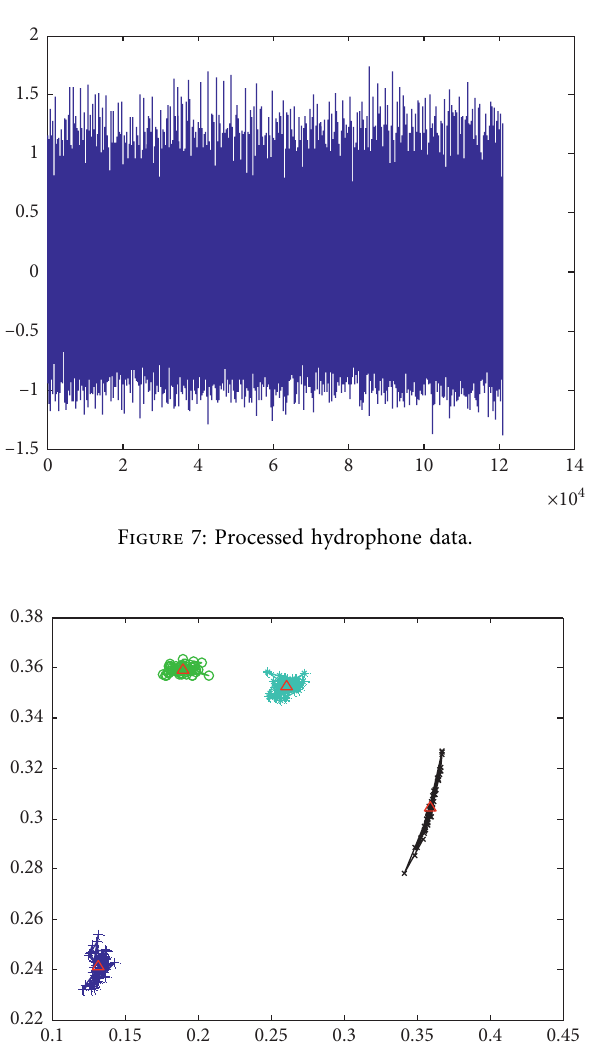
Figure 8: Hydrophone data after fault